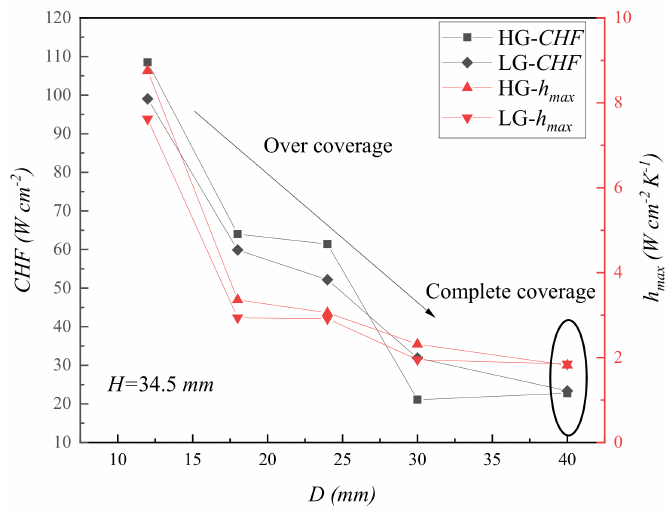
Figure 17. CHF and h max versus D at H = 34.5